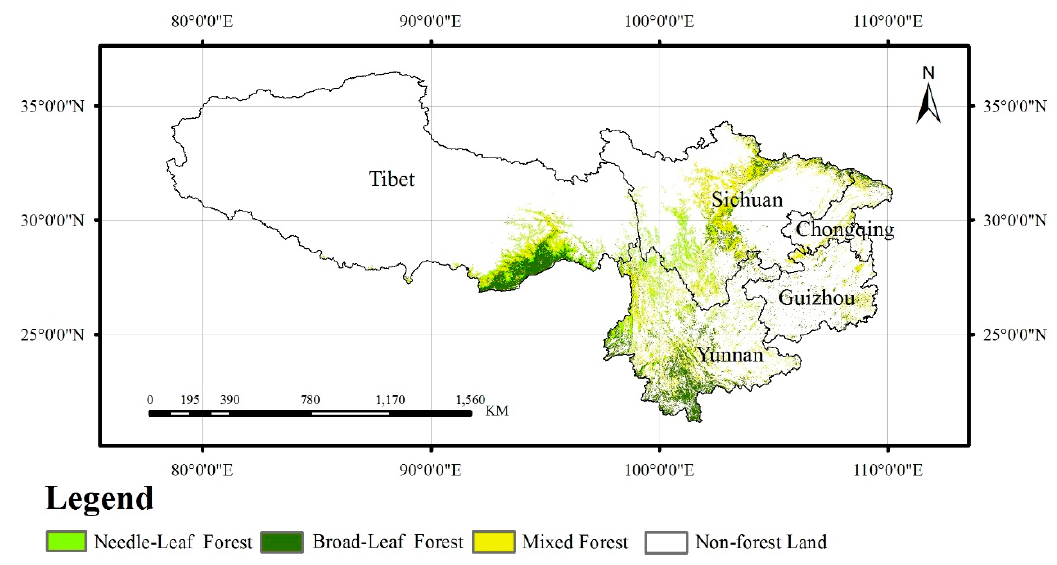
Figure 1. Distribution of forest types in southwest China in 2013.